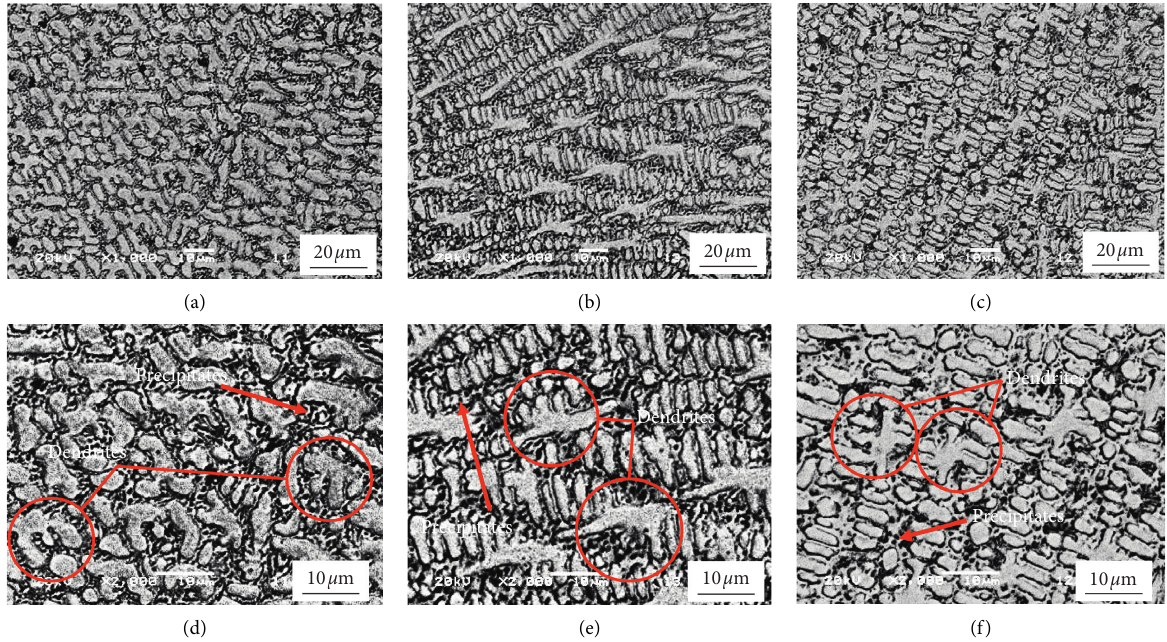
Figure 5: SEM images in backscattered electron mode of the cross-section microstructures of (a, d) C1, (b, e) C2, and (c, f) C3